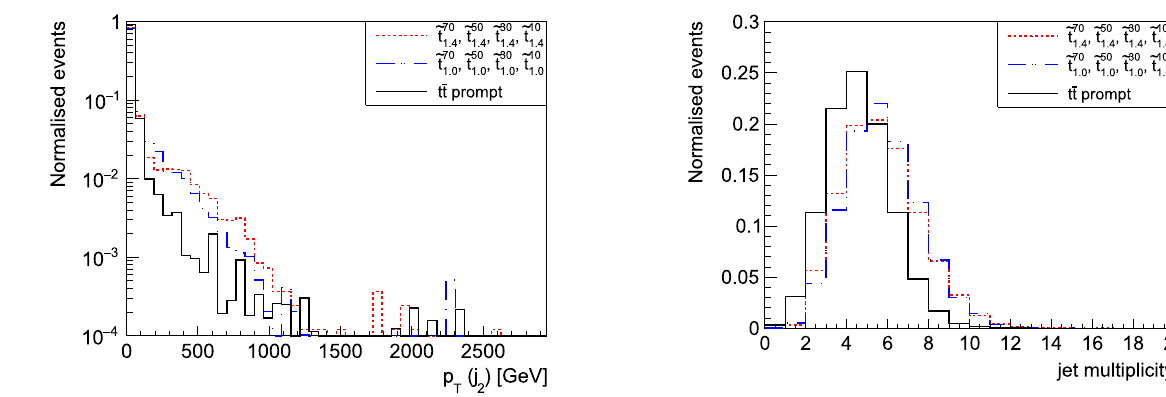
Fig. 56 Transverse momentum p T of the second leading jet in the stop squark ˜ t case